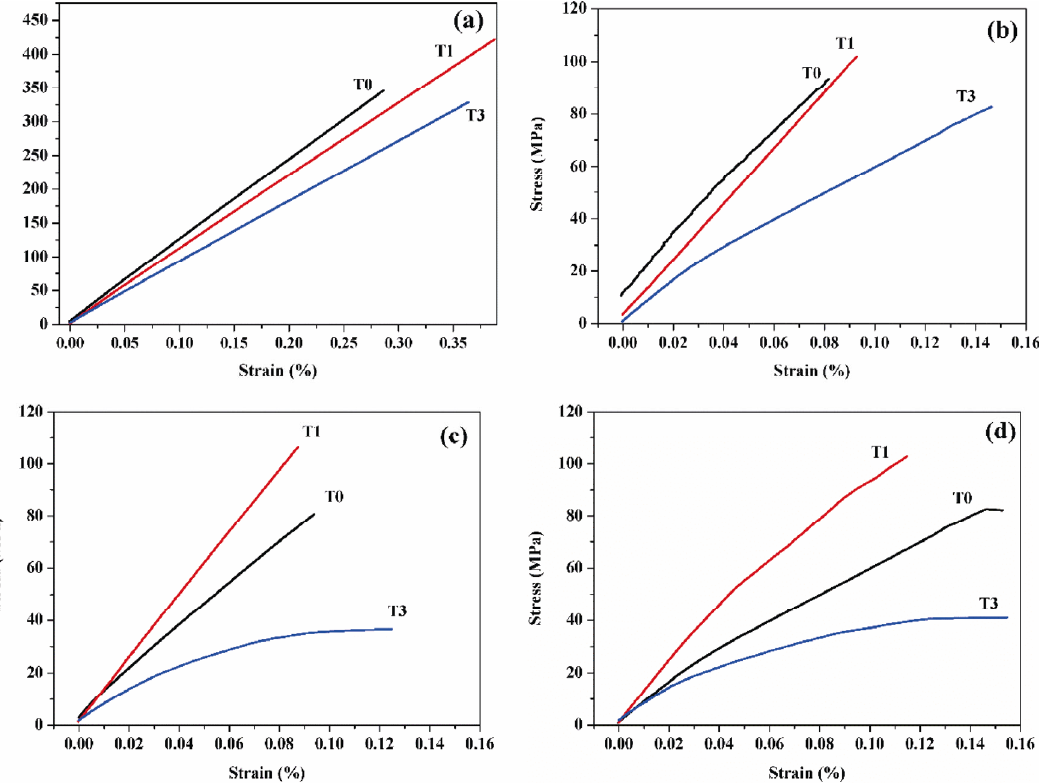
Fig. 5 Stress–strain curves of Si 2 BC 3 N ceramics with various number of thermal shock cycles at Δ T = 1000 ℃ : (a) before thermal shock, (b) one cycle, (c) two cycles, and (d) three